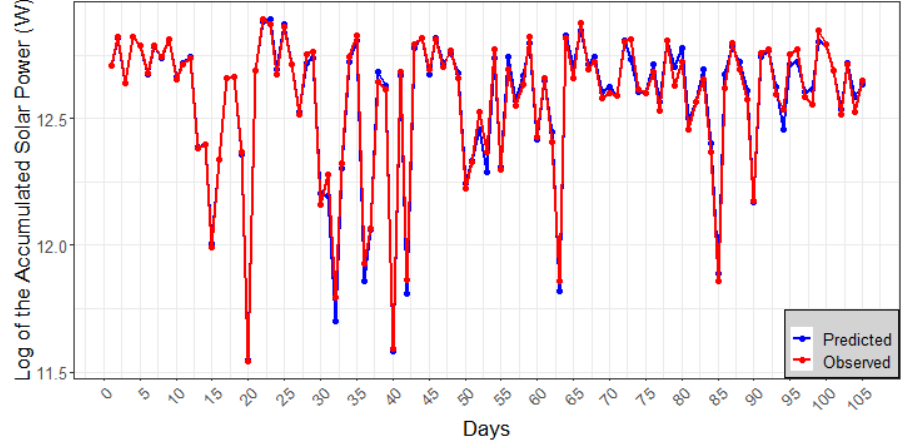
Figure 11. The total predicted ( blue ) and observed ( red ) generated power values from October